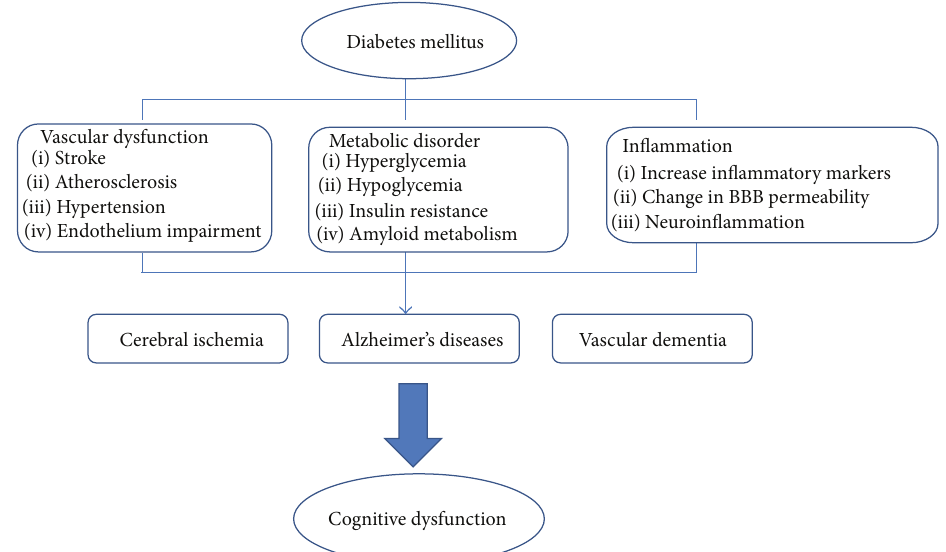
Figure 1: Mechanism of DM-mediated cognitive